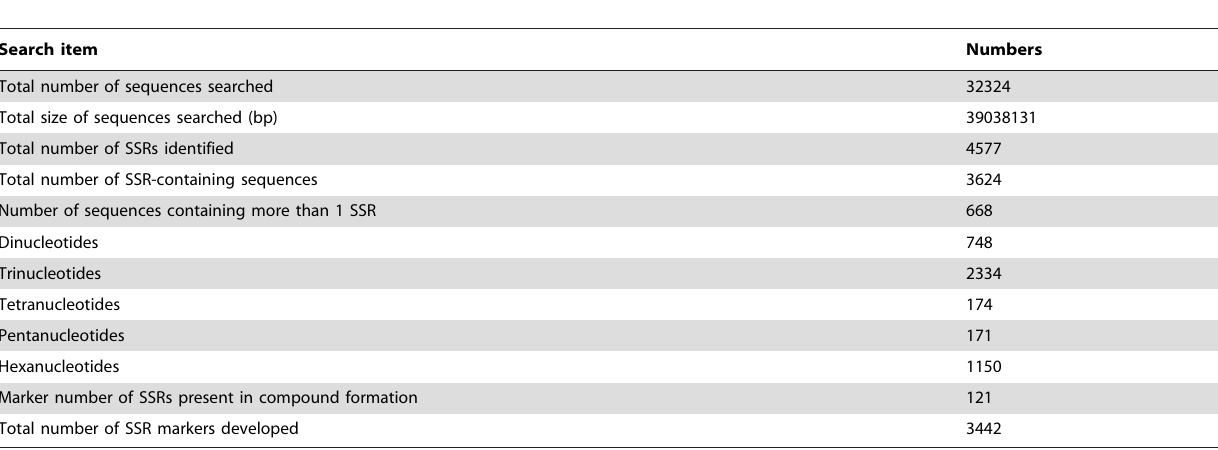
Table 1. Results of searches for EST-SSRs in